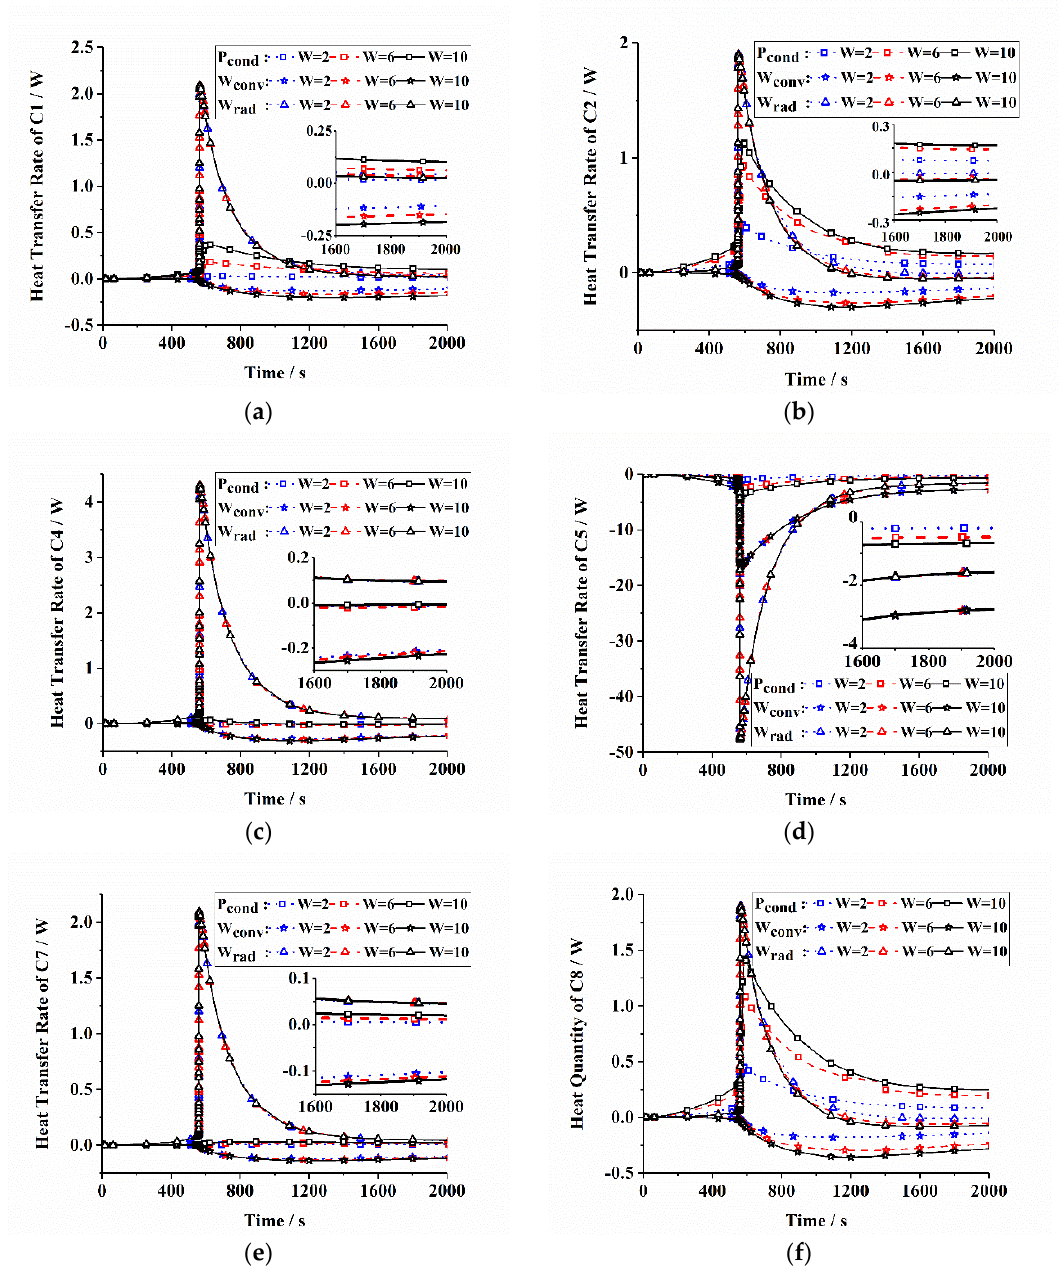
Figure 5. Heat transfer rates with different heat transfers of each cell when W = 2, 6 and 10 mm (S = 4 = 1mm); ( a ) C1, ( b ) C2, ( c ) C4, ( d ) C5, ( e ) C7, ( f ) mm, R s = 1mm); ( a ) C1, ( b ) C2, ( c ) C4, ( d ) C5, ( e ) C7, ( f ) C8. (S = 4 mm, R s